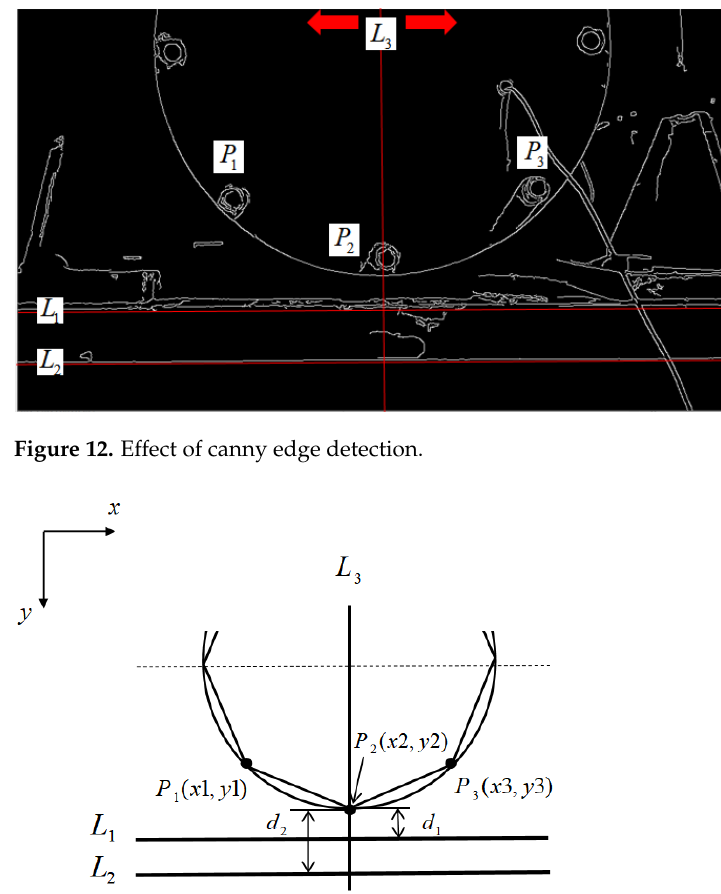
Figure 13. Simplified geometric model of end cover and bolt.